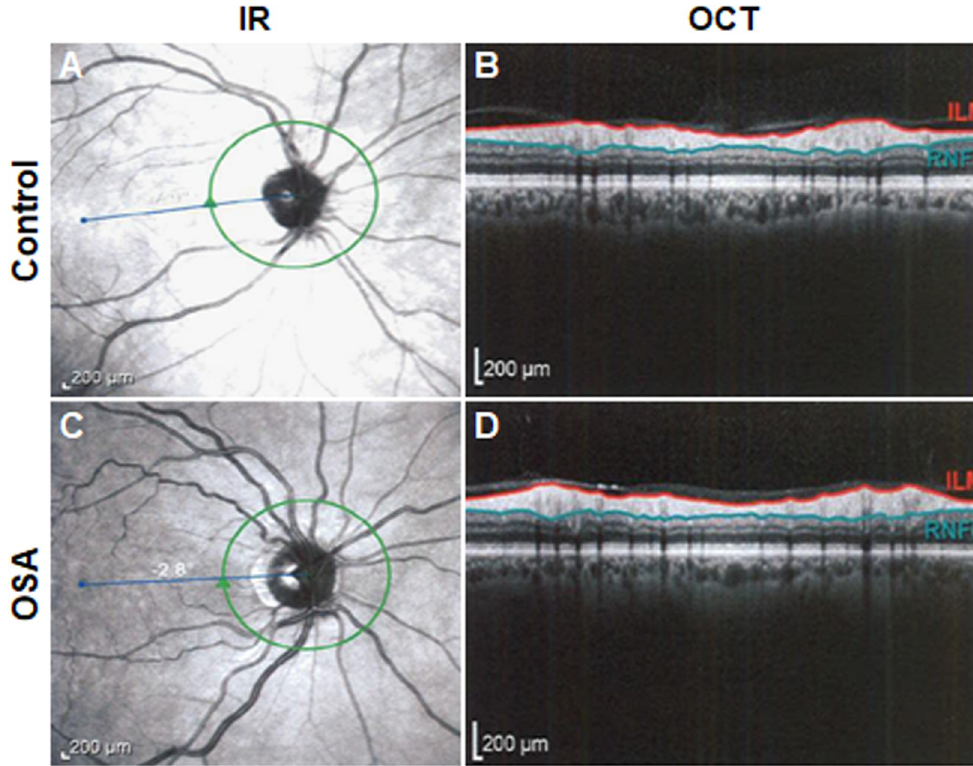
Fig 3. Quantification of the RNFL. The data presented in Tables 4 and 5 were obtained through multiple measurements around the optic nerve head (green circle) recording the thickness between the inner limiting membrane (ILM; red) and the RNFL (blue). (A) Representative infrared (IR) image depicting the region where the scans were collected in a control patient. (B) Representative optical coherence tomography (OCT) image from the control patient highlighting one measurement collected for thickness quantification between the ILM and RNFL. (C) Representative IR image depicting the region where the scans were collected in a patient with OSA. (D) Representative OCT image from the control patient highlighting one measurement collected for thickness quantification between the ILM and RNFL. Scale bar: 200 μ m.